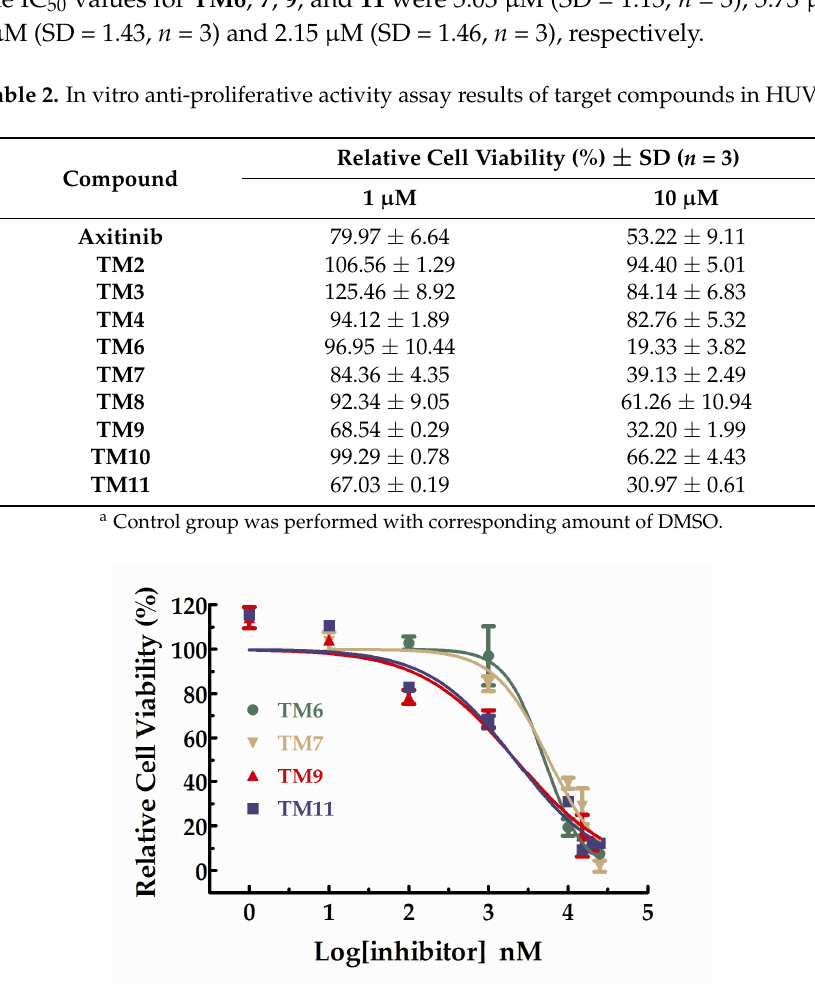
Table 2. In vitro anti-proliferative activity assay results of target compounds in HUVEC.